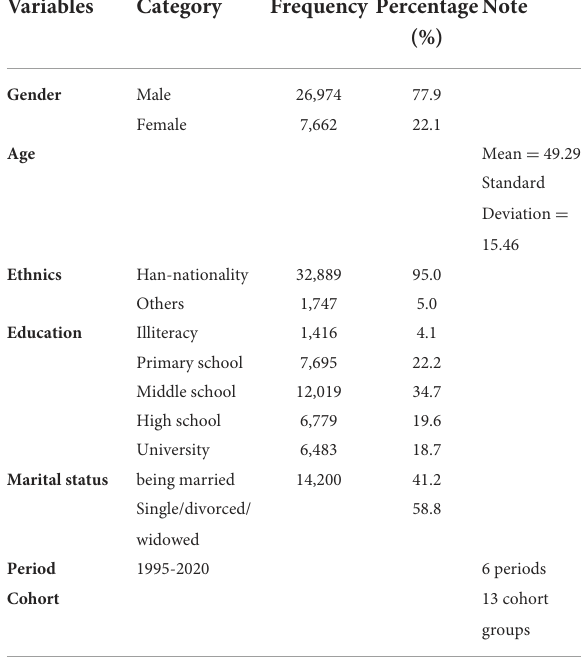
TABLE 2 Estimation of age-period-cohort effect on the trends of human immunodeficiency virus (HIV) infection via blood transmission during 1995–2020 in Hubei,